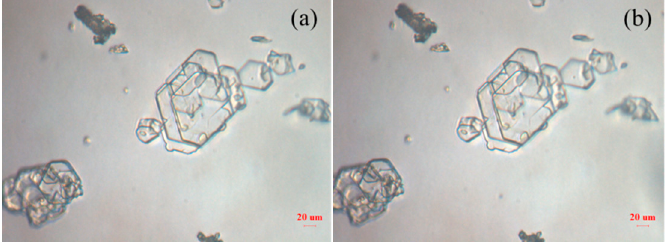
Figure 7. The DSC curve (red color), TG curve (black color) and DTG curve (blue color) of Solid II.